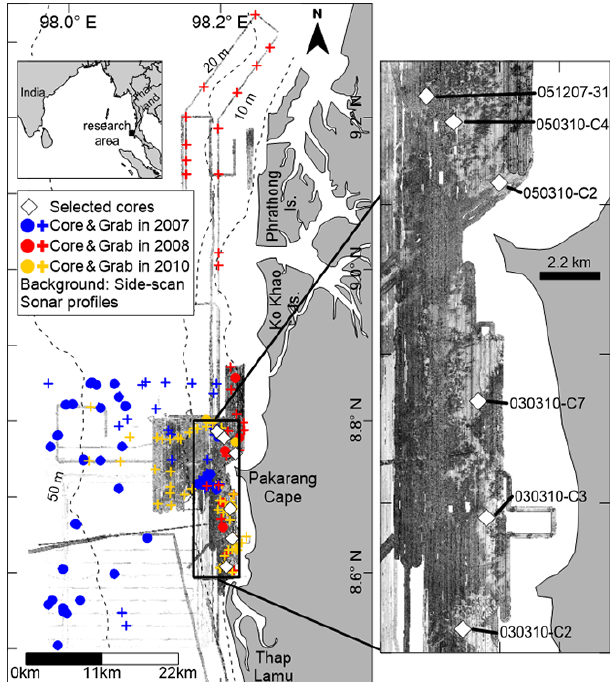
Figure 1. Overview map of the investigation area including sam- pling stations. The bathymetric data are based on nautical charts. The sediment samples taken during the 3-year research period on the three different cruises are presented in difference colors.